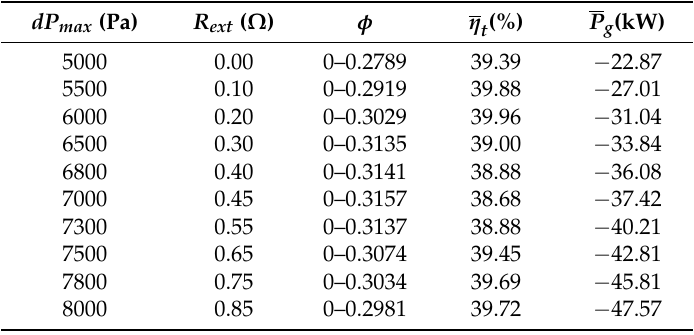
Table 3. Performance of MPPT algorithm with manual look-up-table